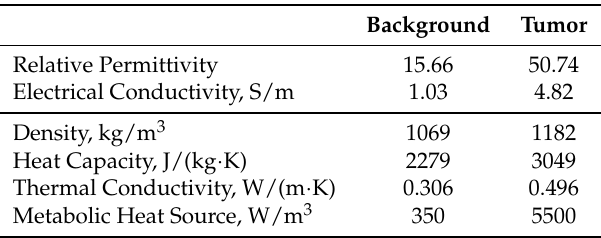
Table 1. Electromagnetic and heating properties used in the heating simulation. Both regions share the same properties for: arterial blood temp = body temperature, specific heat of blood = 1 J/(kg · K), blood perfusion rate = 1 Hz, and density of blood = 1000 kg/m 3